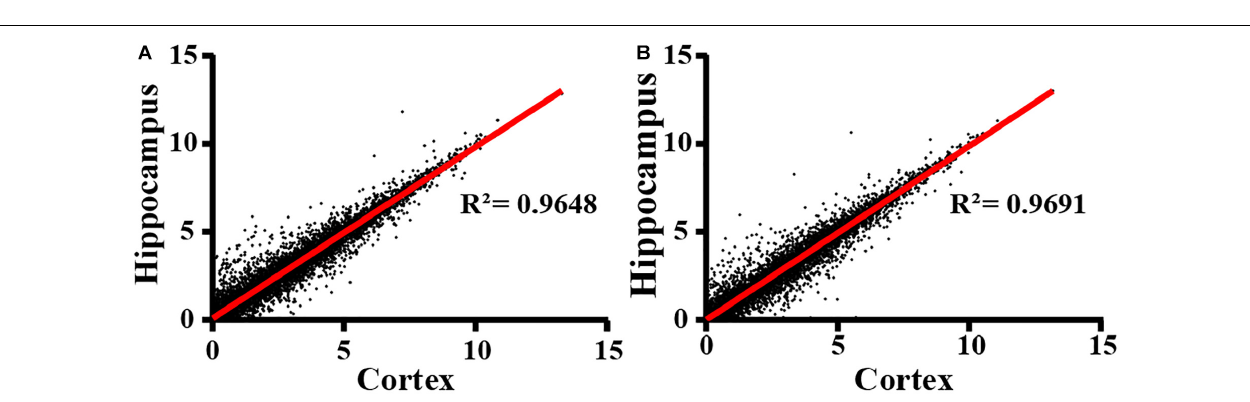
FIGURE 2 | Correlation of RNA expression profiles between cortex and hippocampus. Cortex and hippocampus are computed for sample correlation by Pearson’s correlation analysis in IL15R α − / − group (A) and control group (B) , respectively. Pearson’s correlation coefficient is represented by R 2